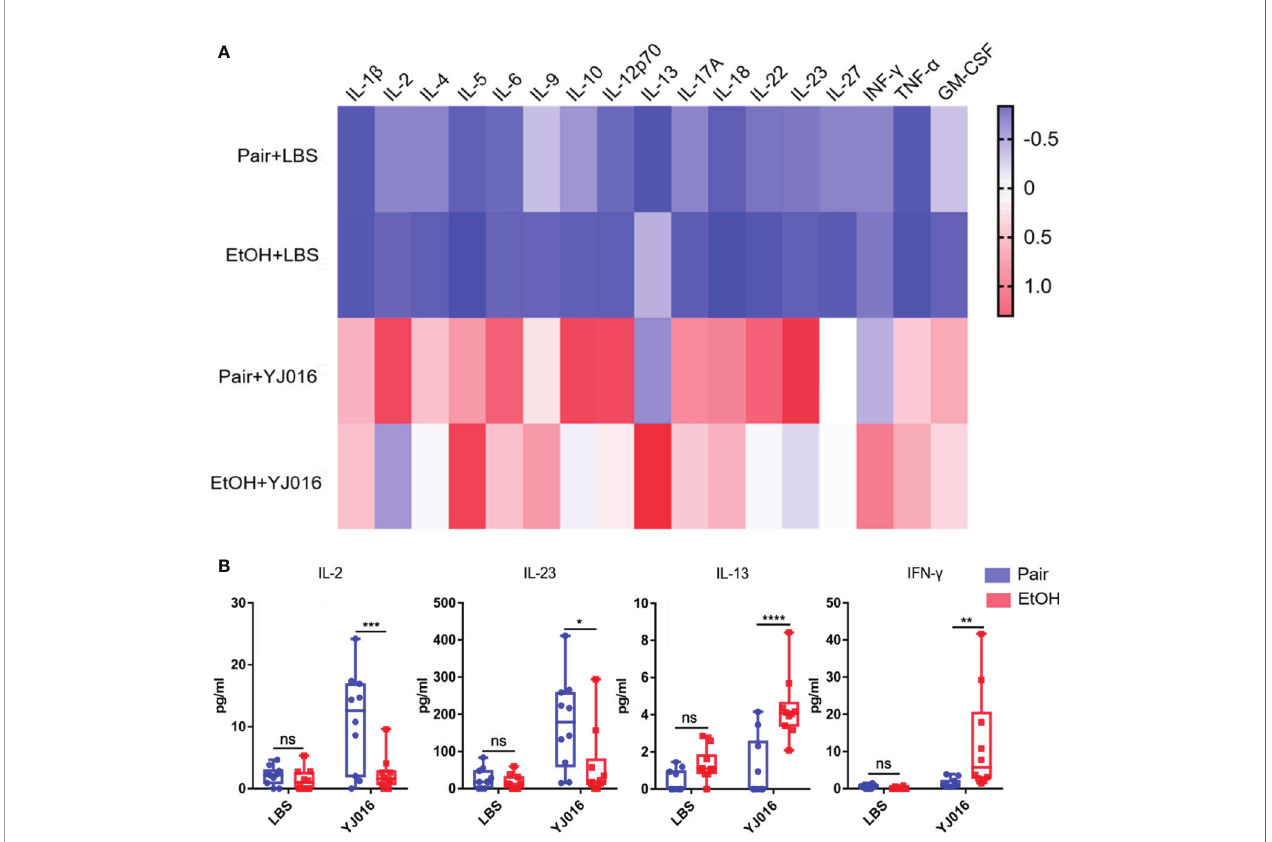
FIGURE 7 | Cytokine concentrations in the Pair and EtOH groups. (A) . The values of cytokines concentrations were standardized by z-score, and the means were used to draw the heat map with red indicating a higher concentration and blue indicating a lower concentration (n = 10). (B) Cytokines with signi fi cantly different concentrations in the EtOH and Pair groups after YJ016 infection (n = 10). The plasma levels of IL-2 and IL-23 in the Pair group were higher than those in the EtOH group; IL-13 and IFN- g were lower in the EtOH group than those in the Pair group. (* P < 0.05, ** P < 0.01, *** P < 0.001, **** P <